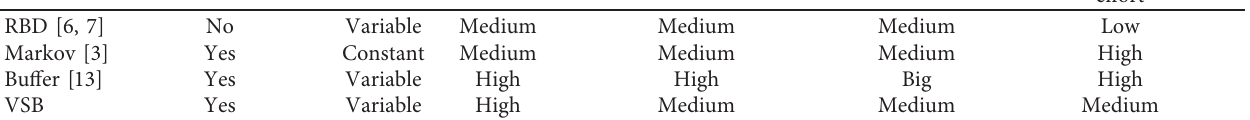
Table 1: Comparison between methodologies for temporal operational continuity modelling. Model